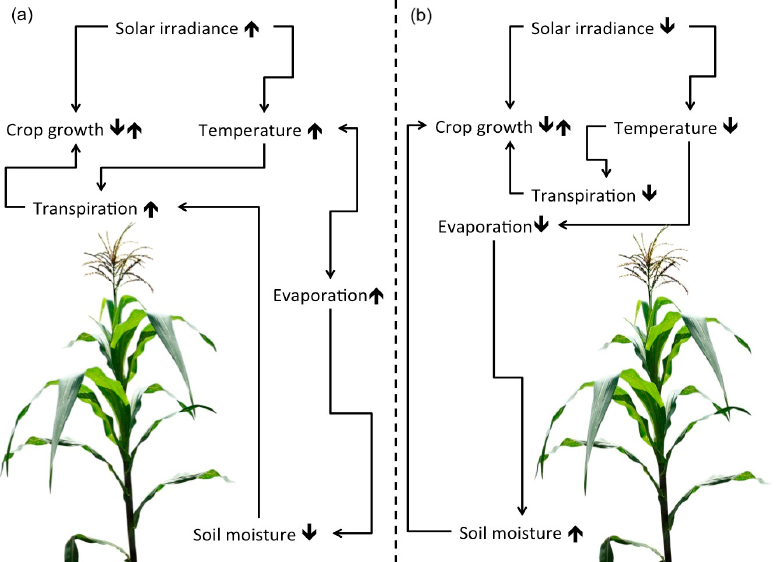
Figure 1. Relationship of processes according to higher ( a ) and lower ( b ) solar irradiance that affect the plant growth.